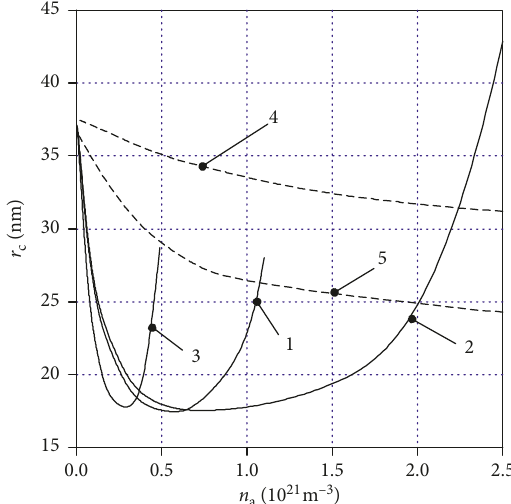
Figure 5: Dependence of the particle radius of Al concentration of additives’ atoms for a monodisperse aerosol taking into account the polarization interaction of Al 2 O 3 particles ( T � 3200K, n Al � 0.5 · 10 22 m − 3 ).1, K 2 CO 3 ; 2, KCl; 3, CsI; 4, LiCl; 5, NaCl.